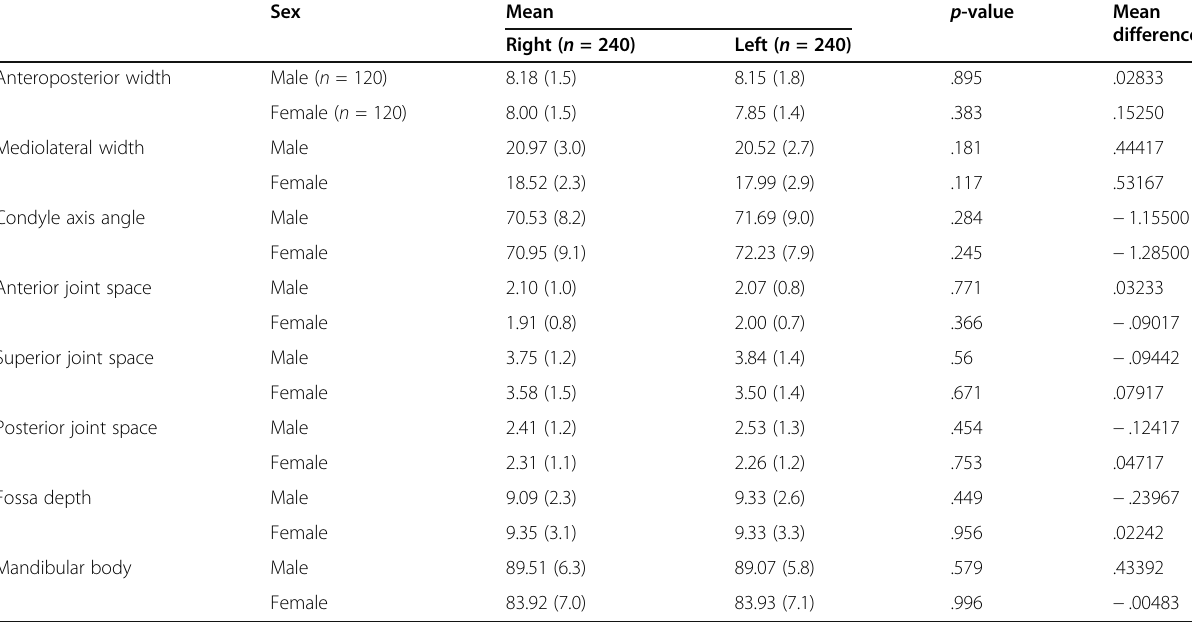
Table 2 Table comparing left and right based on gender